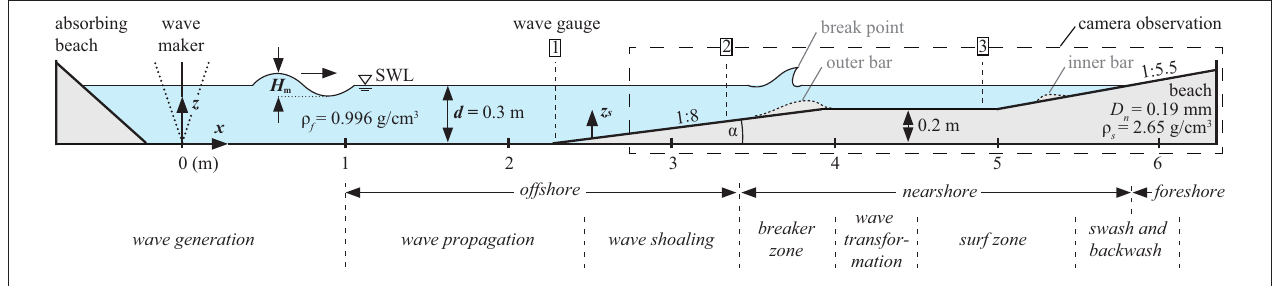
FIGURE 2 | Side view of the experimental set-up with wave maker, ultra-sonic wave gauge location, reference bed profile ( t